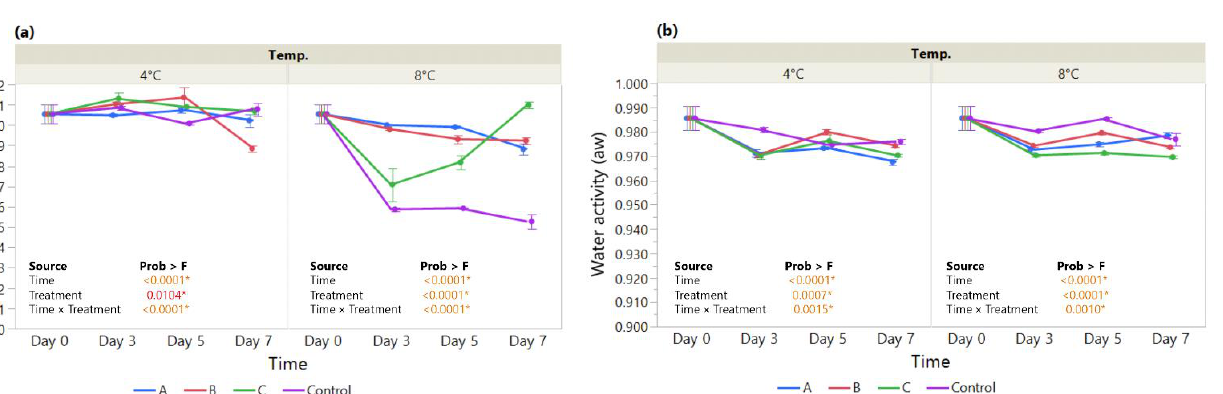
Figure 2. Scanning electron microscopy (SEM) images of ( a ) strawberry coated with medium mo- lecular weight chitosan, acetic acid, and grape seed EO (magnification 500×); ( b ) strawberry coated with medium molecular weight chitosan, acetic acid, and sea buckthorn EO; ( c ) strawberry coated with high molecular weight chitosan, ascorbic acid, and grape seed EO; ( d ) apple slices coated with medium molecular weight chitosan, acetic acid, and grape seed EO (magnification 500×); ( e ) apple slices coated with medium molecular weight chitosan, acetic acid, and sea buckthorn EO; and ( f ) apple slices coated with high molecular weight chitosan, ascorbic acid, and grape seed EO.